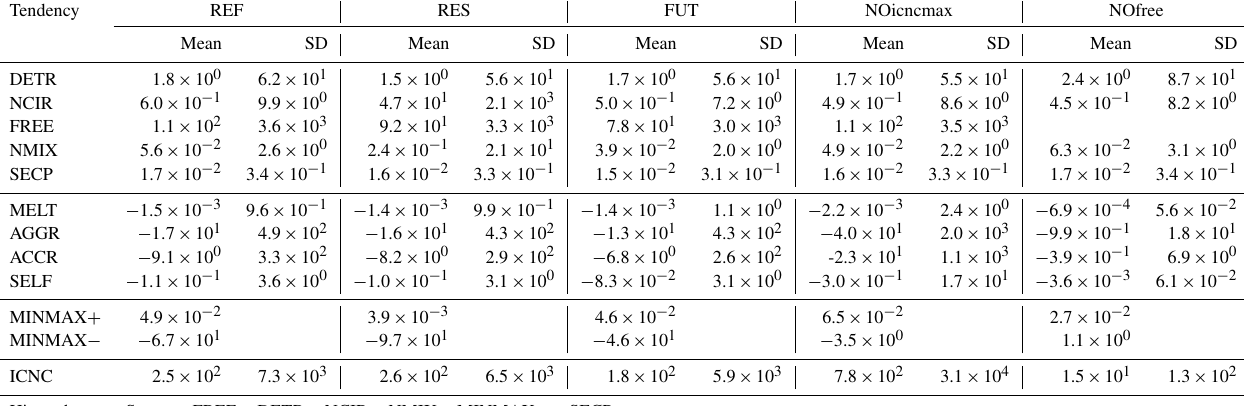
Table 4. Statistics computed by using 5-hourly output of the 5-year simulations REF, PRES, and FUT and the 1-year simulations NOicncmax and NOfree. Global means and standard deviations (SDs) are in m − 3 s − 1 for the tendencies and in L − 1 for grid-averaged ICNC. MINMAX + and MINMAX − are the sum of the means of positive and negative numerical tendencies, respectively (according to Table 2). The last two rows summarize the hierarchy of the ICNC tendencies in REF.